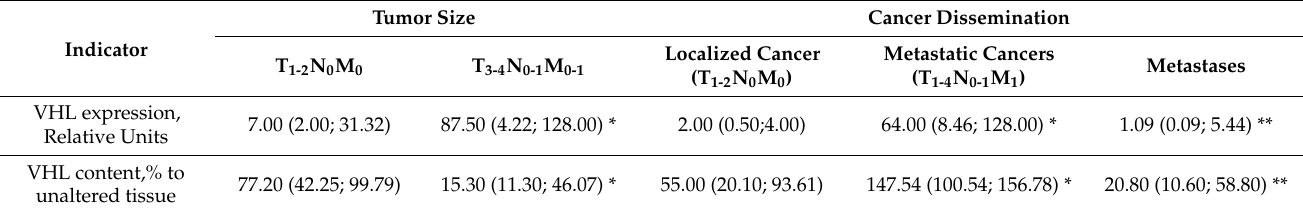
Table 2. Expression and content of VHL in tumor tissue of patients depending on tumor size and disease spreading, Me (Q1; Q3).